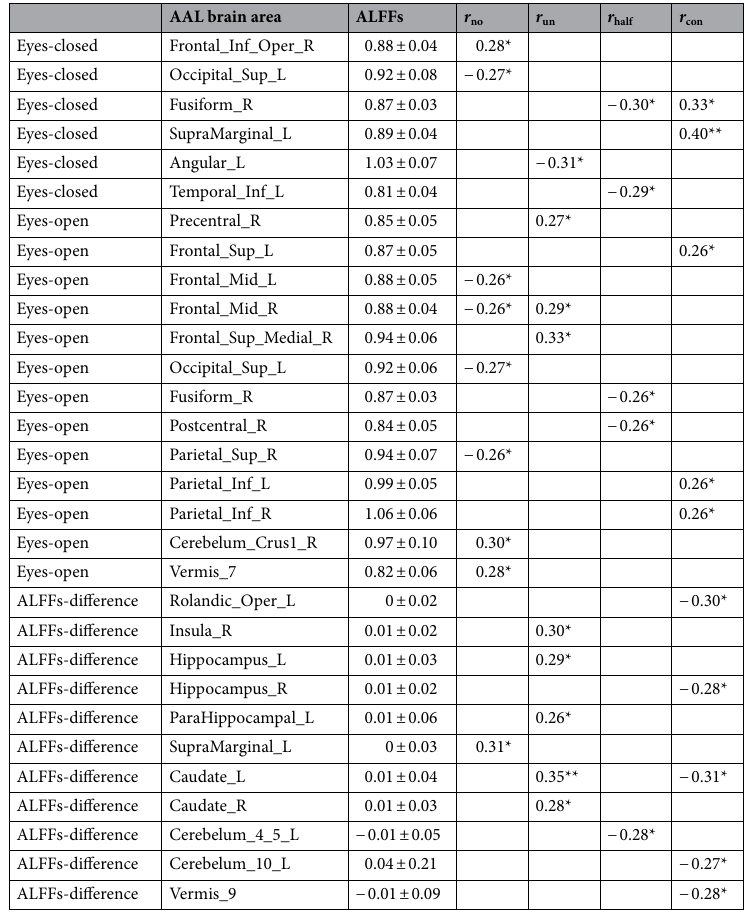
Table 4. Correlations between ALFFs/ALFFs-difference with the four MET knowledge. r no is the correlation between ALFFs/ALFFs-difference and no-acquisition; r un is the correlation between ALFFs/ALFFs-difference and uncontrollable knowledge; r half is the correlation between ALFFs/ALFFs-difference and half-controllable knowledge; r con is the correlation between ALFFs/ALFFs-difference and controllable